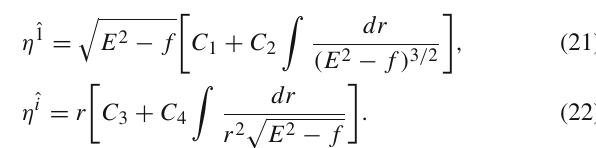
, R atf , r − , and r + with the coupling 0 0